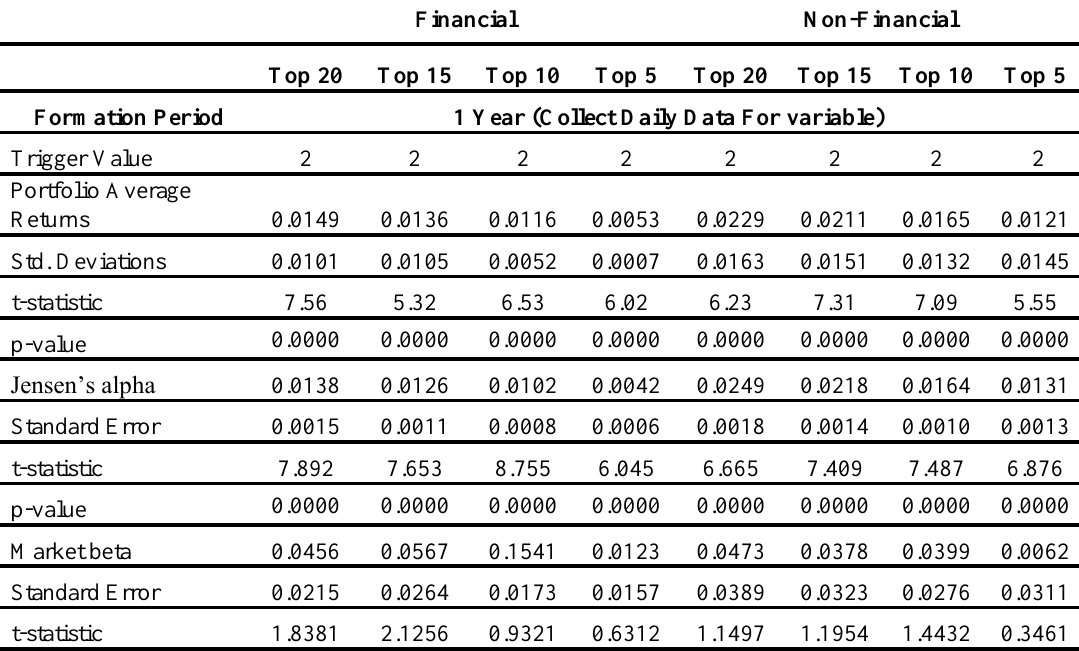
Table.3. Comparison of Financial and Non-Financial Sector (Distance